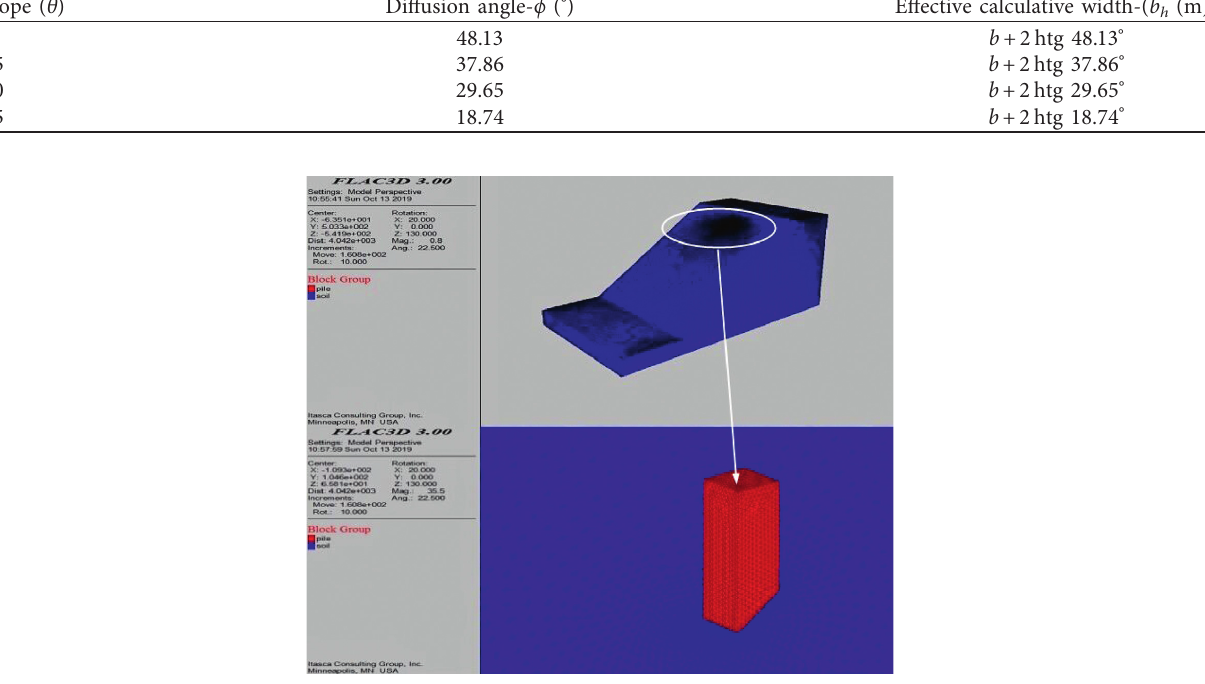
Figure 19: Generalization numerical model at 45 ° . Table 6: Material calculation parameters of the numerical model.